Question: Identify the chart type used in this figure.
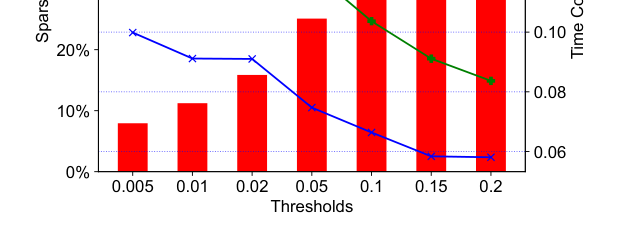
Answer: bar